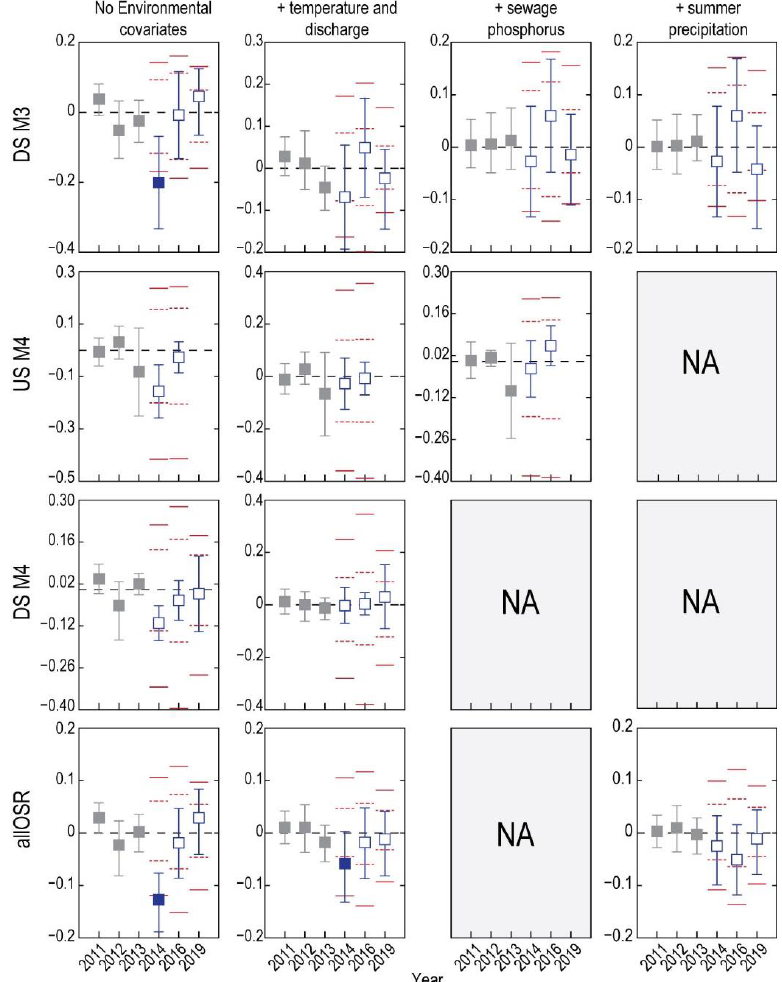
Figure 2. Median residual gonad weight (GW) of female white sucker (± log 10 ; g) from site-specific regressions done without environmental covariates, with T and D, with T, D, and P, and either T, D, P, and Pr, or T, D, and Pr; “NA” indicates a non-applicable analysis; upper and lower dashed horizontal red lines denote 97.5 and 2.5 percentiles, respectively; upper and lower solid horizontal dashed lines denote outer tolerance limits for the 97.5 and 2.5 percentiles, respectively; error bars in observed test and reference data show 95% confidence intervals; solid symbols suggest a potentially relevant difference; open symbols show potentially irrelevant differences; solid grey symbols denote baseline years (2011–2013) used to derive thresholds used for test years (2014, 2016, 2019).